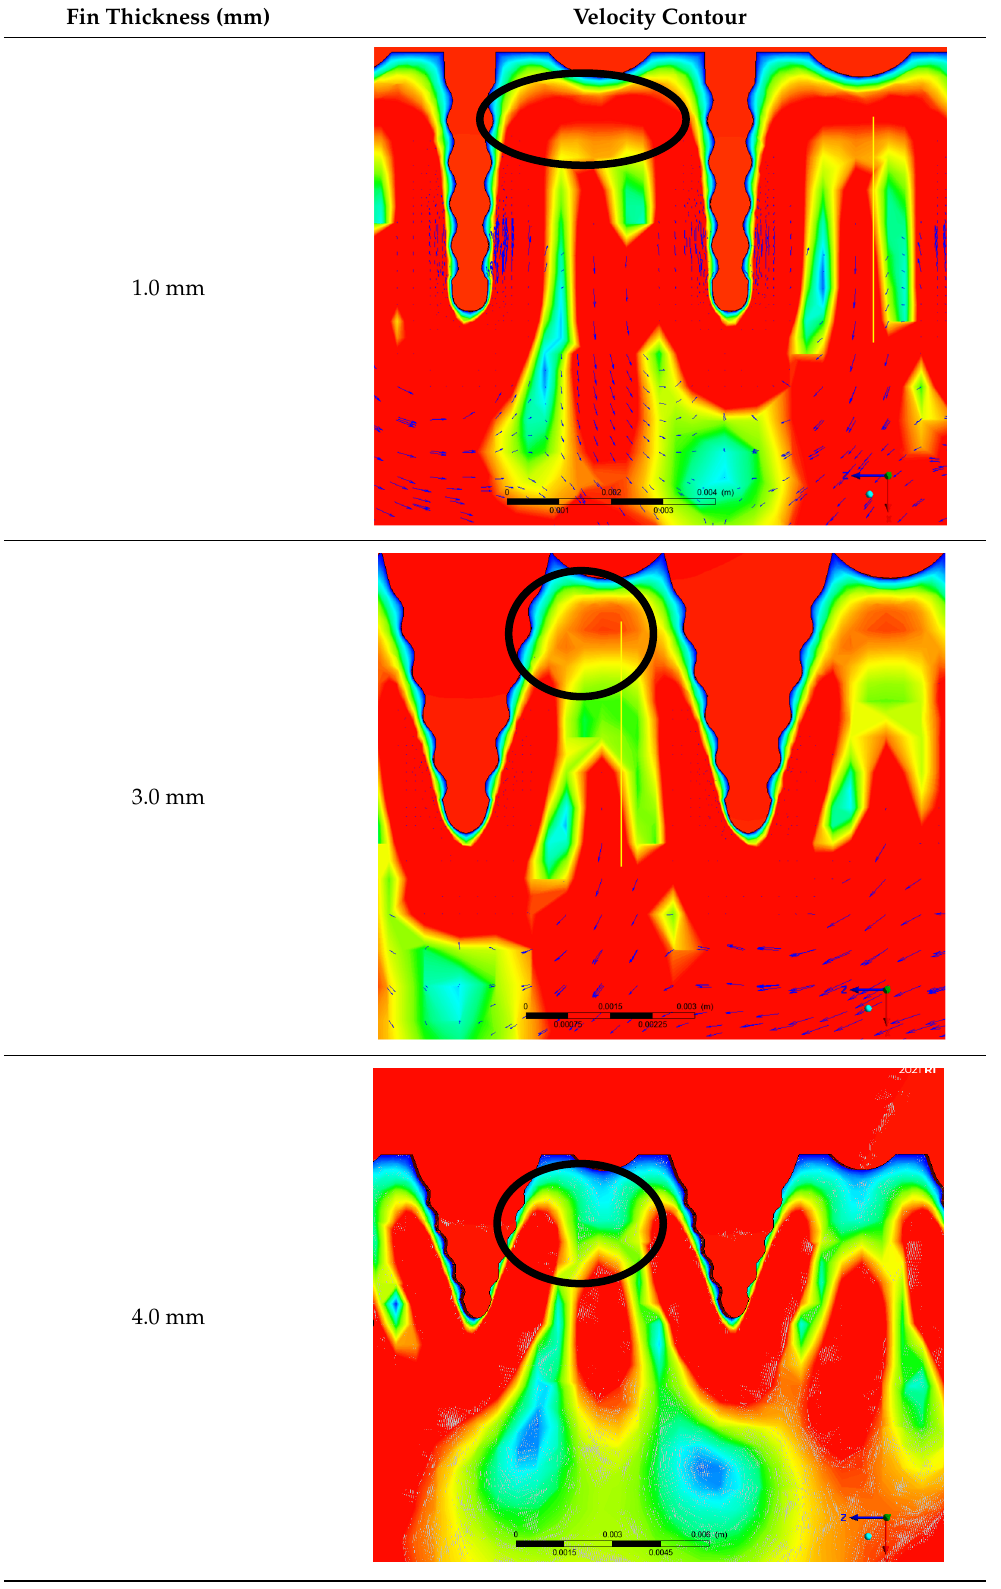
Table 5. Velocity contour and vector for different fin thickness.